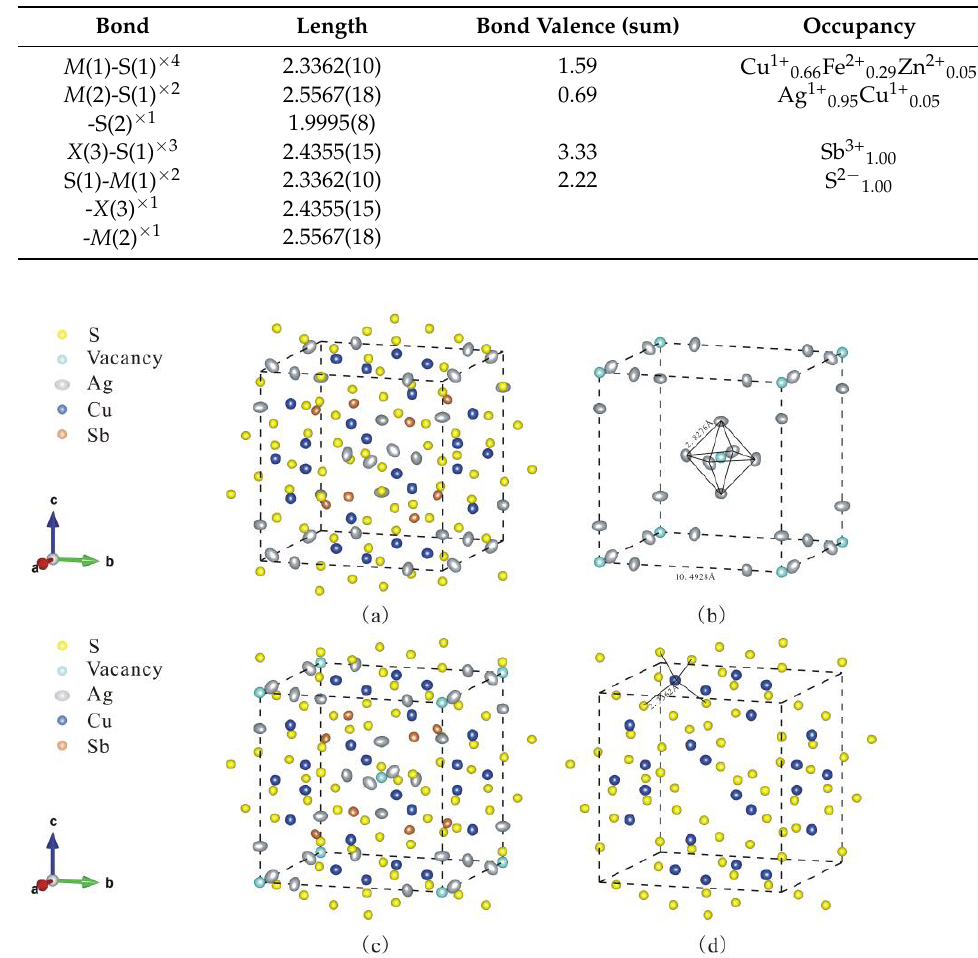
Figure 2. The crystal structure of kenoargentotetrahedrite-(Fe), showing the sites and the anisotropic displacement ellipsoids in the unit cell: ( a ) without the vacancy of the S(2) sites; ( b ) the bond length of Ag-Ag is 2.8277 Å, and the distance of two vacancy sites is 10.4928 Å; ( c ) with the vacancy of the S(2) sites; ( d ) the tetrahedron is composed of Cu and S atoms and the distance between the Cu atom and the adjacent S atoms.